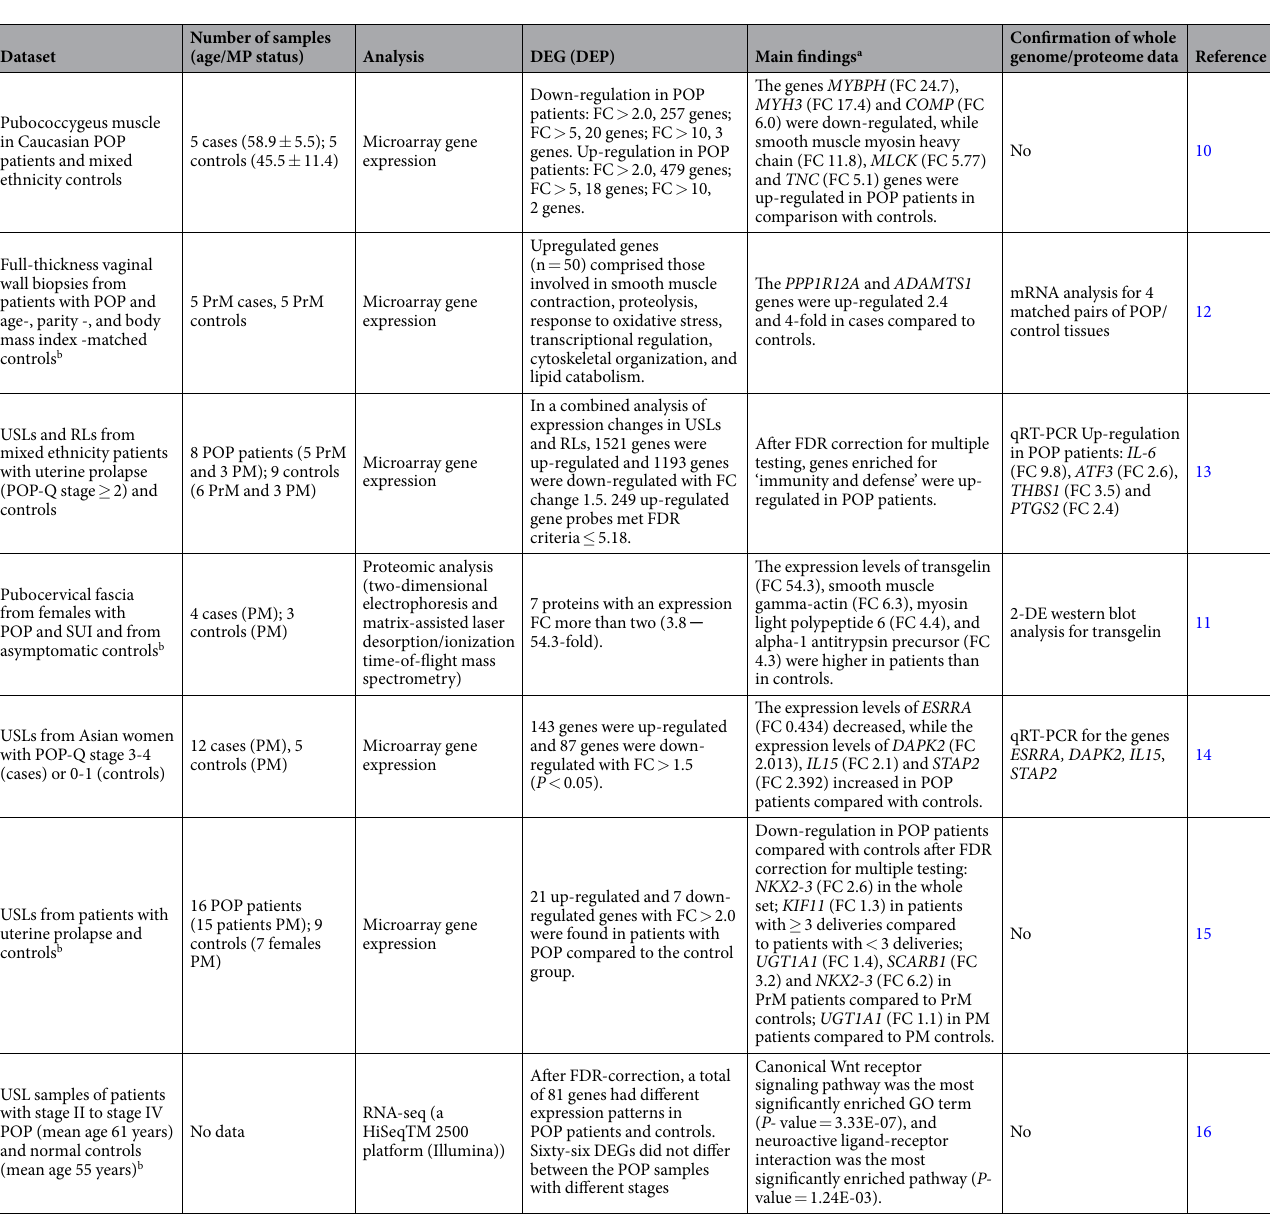
All shared up-regulated genes were tested for enrichment of metabolic pathways and association sig- nals from GWAS data (Table 3). The enriched KEGG pathways were mainly linked with inflammatory and immune-mediated diseases. Of great interest were the results of the enrichment analysis of GWAS association data which indicated that genes associated with inflammatory bowel disease (IBD) and Crohn’s disease (one of the two main forms of IBD) were overrepresented among shared up-regulated genes. These genes (with the exception for the genes SLC22A4, BORCS5 and CNNM1 ) are involved in ‘immune system process’ (GO term). Literature data supporting associations revealed for the shared genes. Several associations revealed in the set of shared genes were partially supported by literature data. Three different kinds of evidence were presented: (i) results on animal models, (ii) evidence from the studies of gene polymorphisms and (iii) expression data for any type of prolapse with the same direction of association. Usage of (iii) as an evidence was based on the rationale that heart valve, cartilage, tendon, and bone development share common regulatory path- ways 26 . The genes ADAMTS1 12 , MYH3 27 and SERPINE1 28 were up-regulated in POP tissues. Polymorphic variants